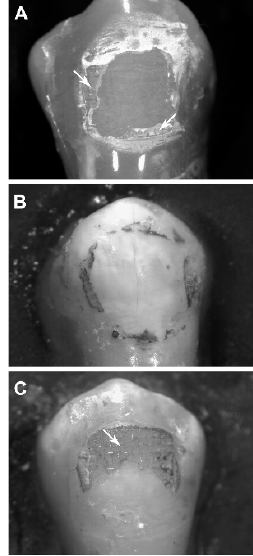
Figure 7. Stereomicroscope imaging at 60× magnification of the tooth samples. White arrows, composite remnants. ( A ) sample from the E group, showing an adhesive remnant index (ARI) score of 1; ( B ) sample from the HA group, showing an ARI score of 0; ( C ) sample from the HA-E group, showing an ARI score of 2.